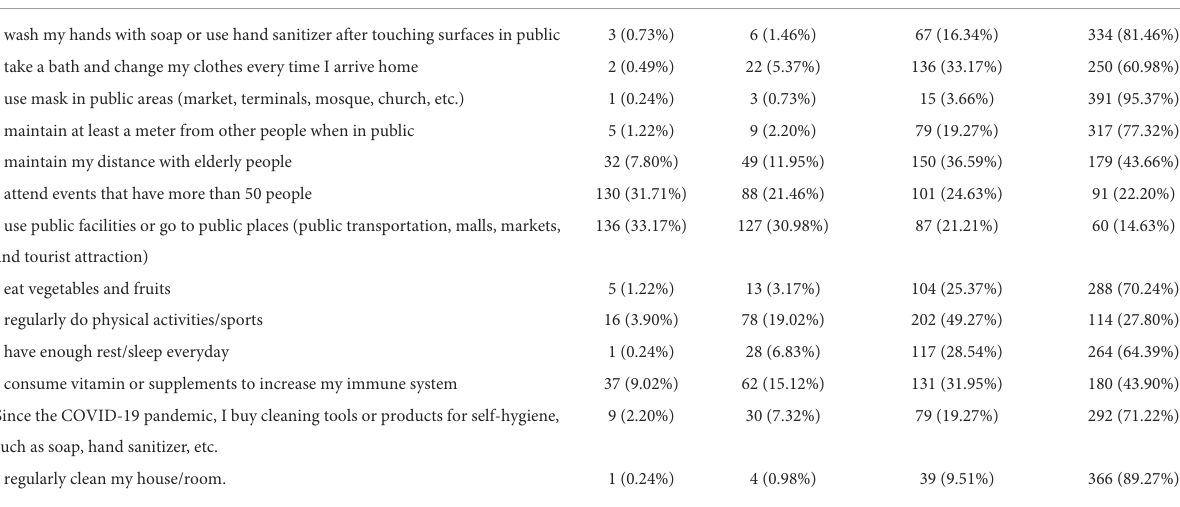
TABLE 2 Frequencies and percentages of every response in each item in practice